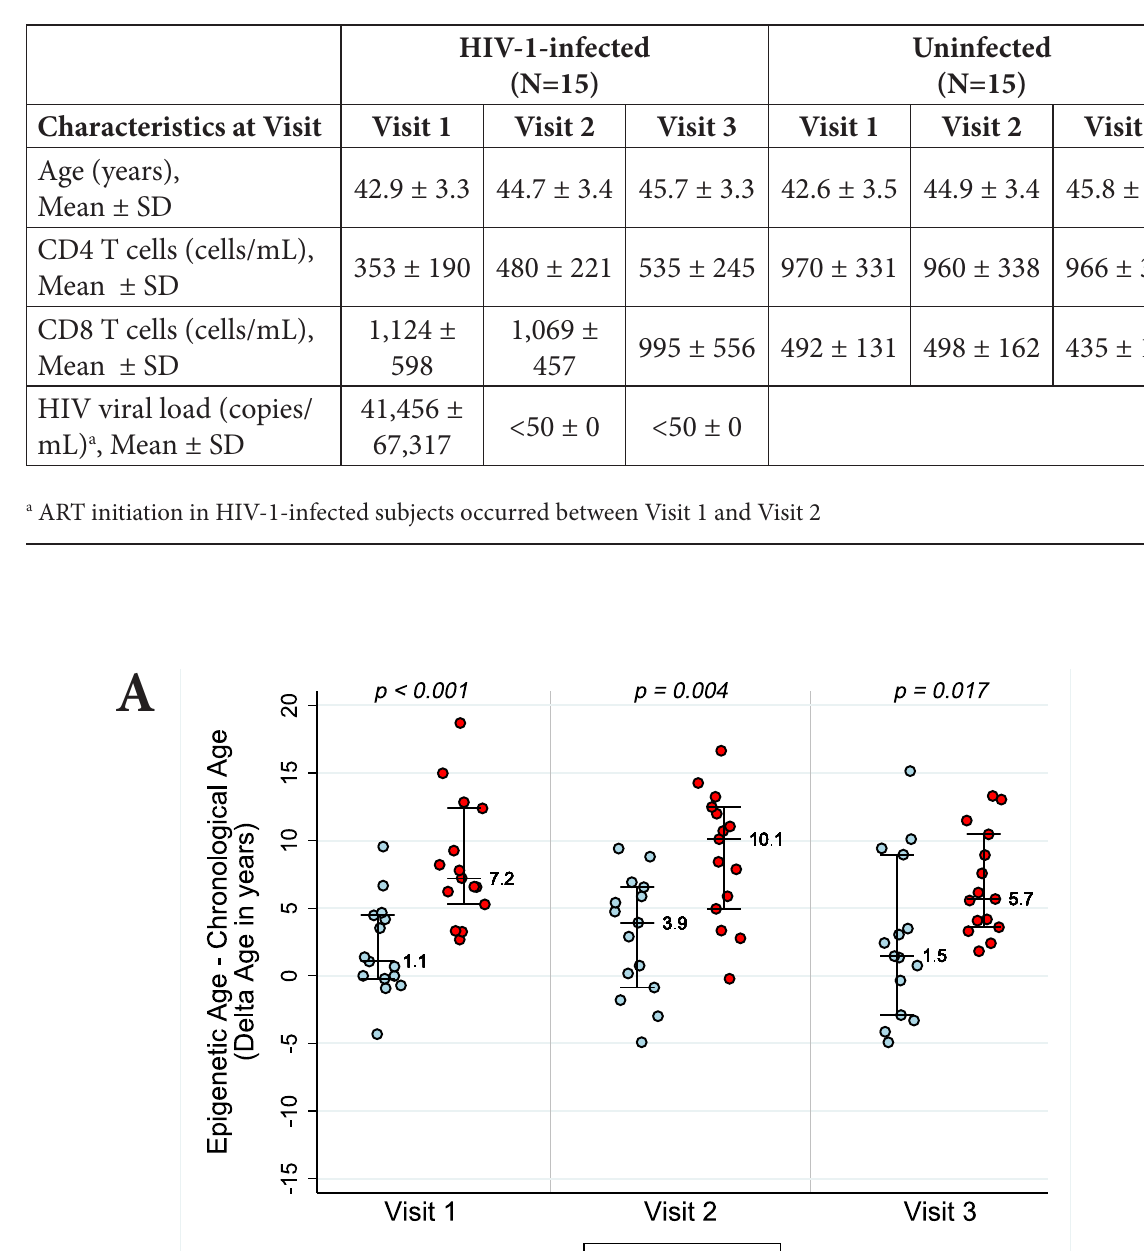
Table 1. Characteristics of subjects at study visits.